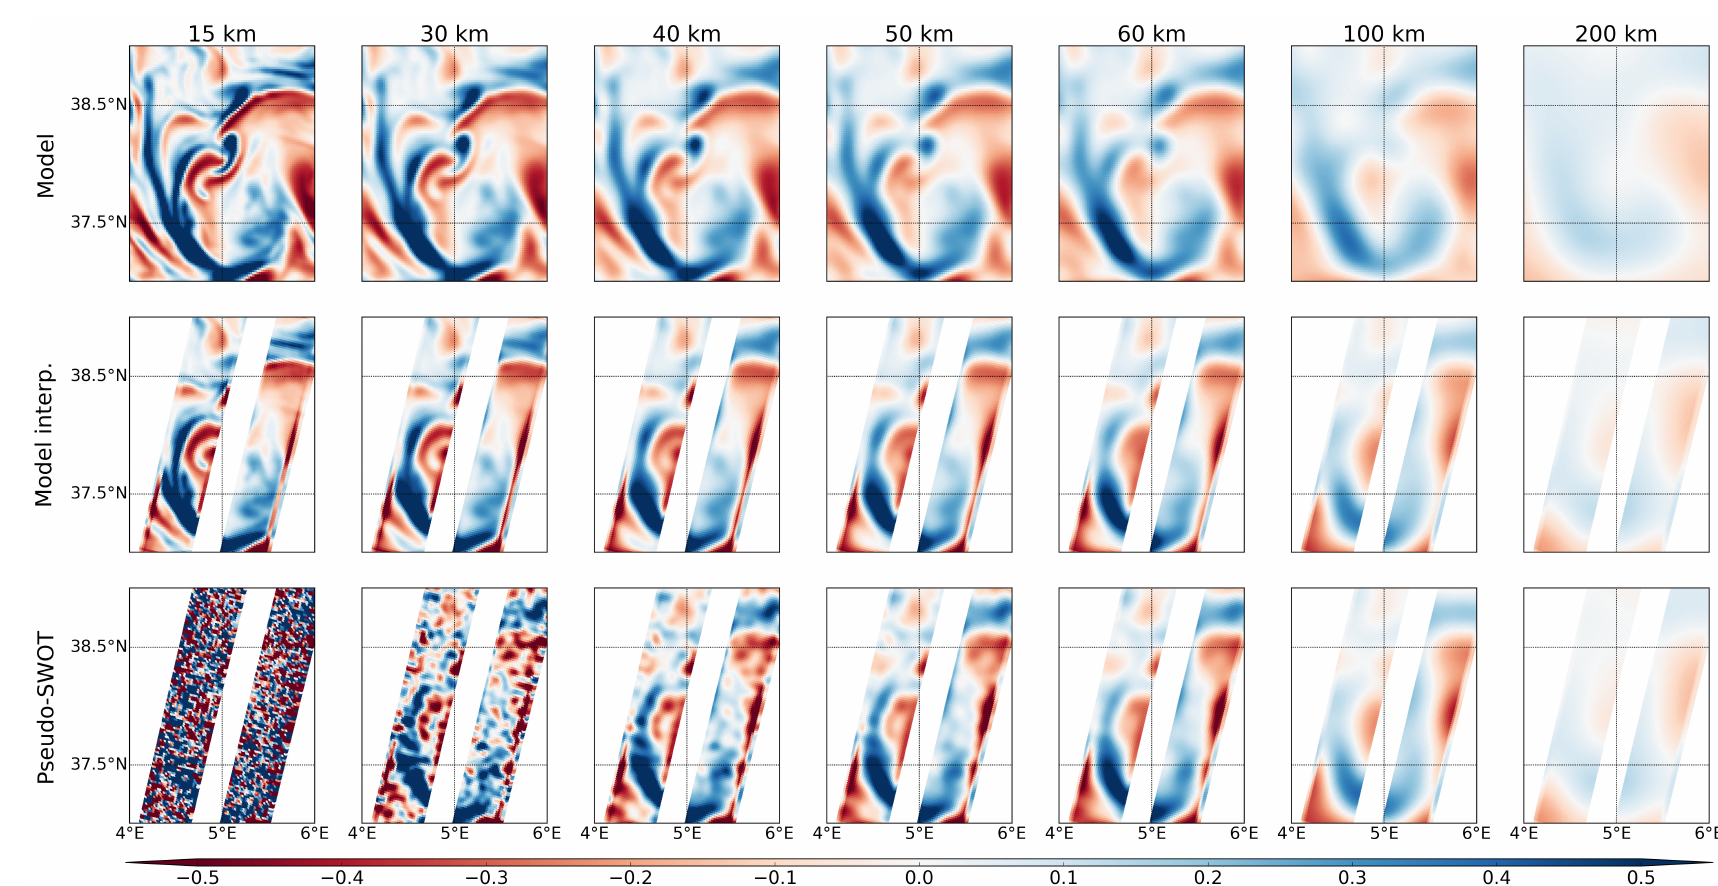
Figure 11. Relative vorticity normalized by f on 23 January 2009 corresponding to pass 15 of cycle